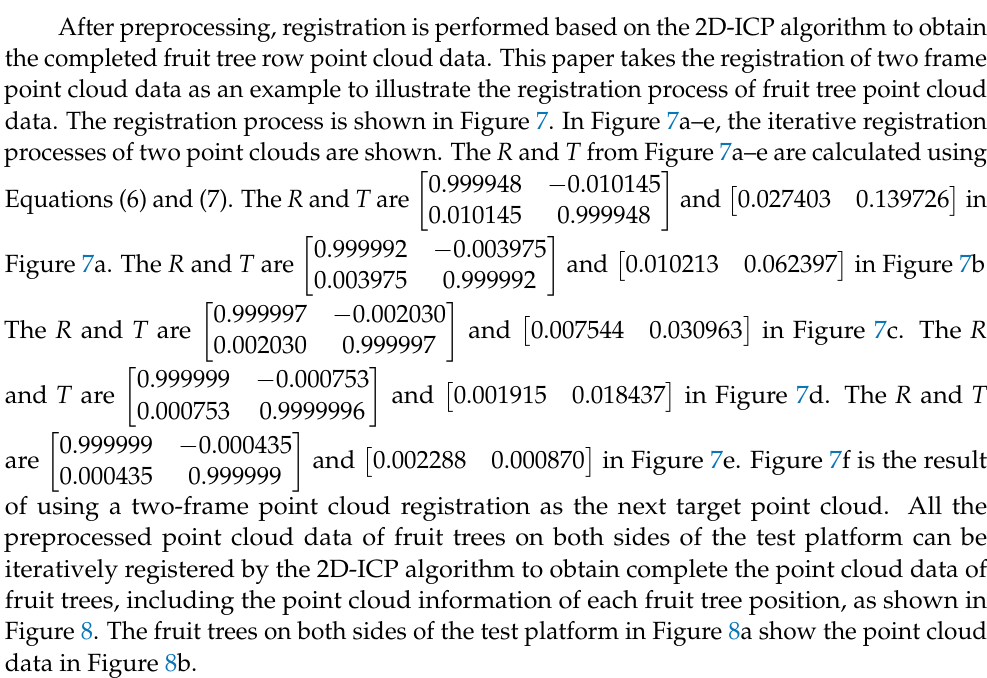
Figure 6. A frame of preprocessed data.